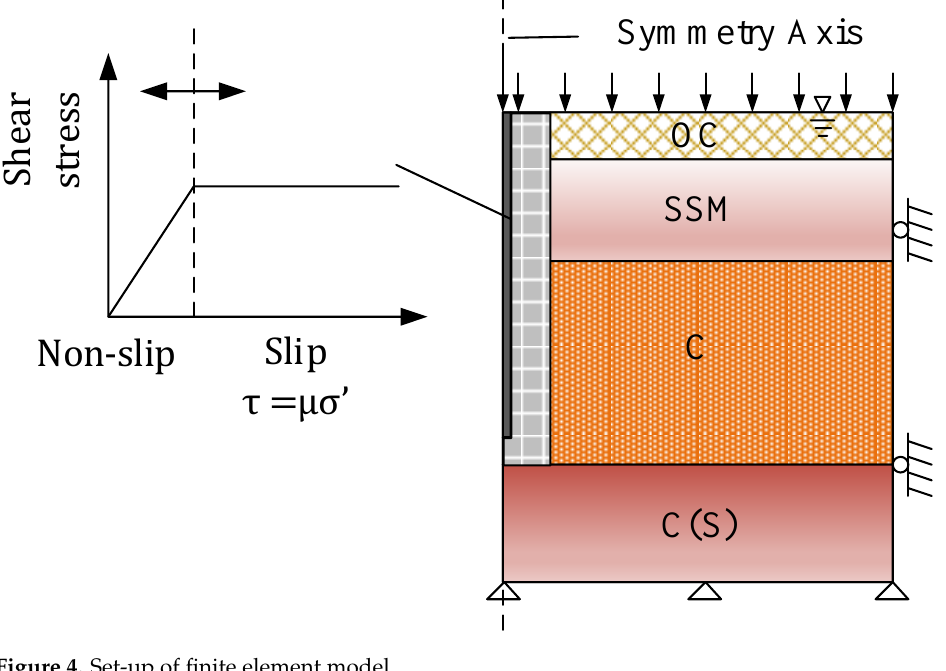
Figure 4. Set-up of finite element model.